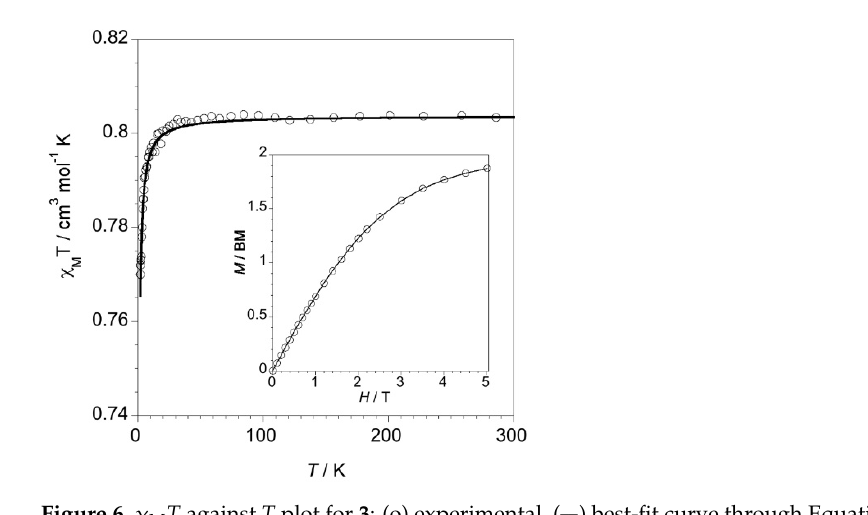
Figure 6. χ M T against T plot for 3 : (o) experimental, ( __ ) best-fit curve through Equation (5) (see text). The inset shows the magnetization versus H plot for 3 at 2.0 K. The solid line is only an eye-guide.